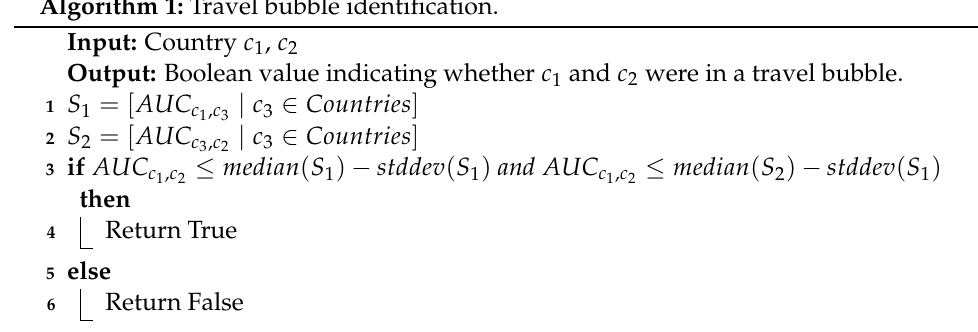
Algorithm 1: Travel bubble